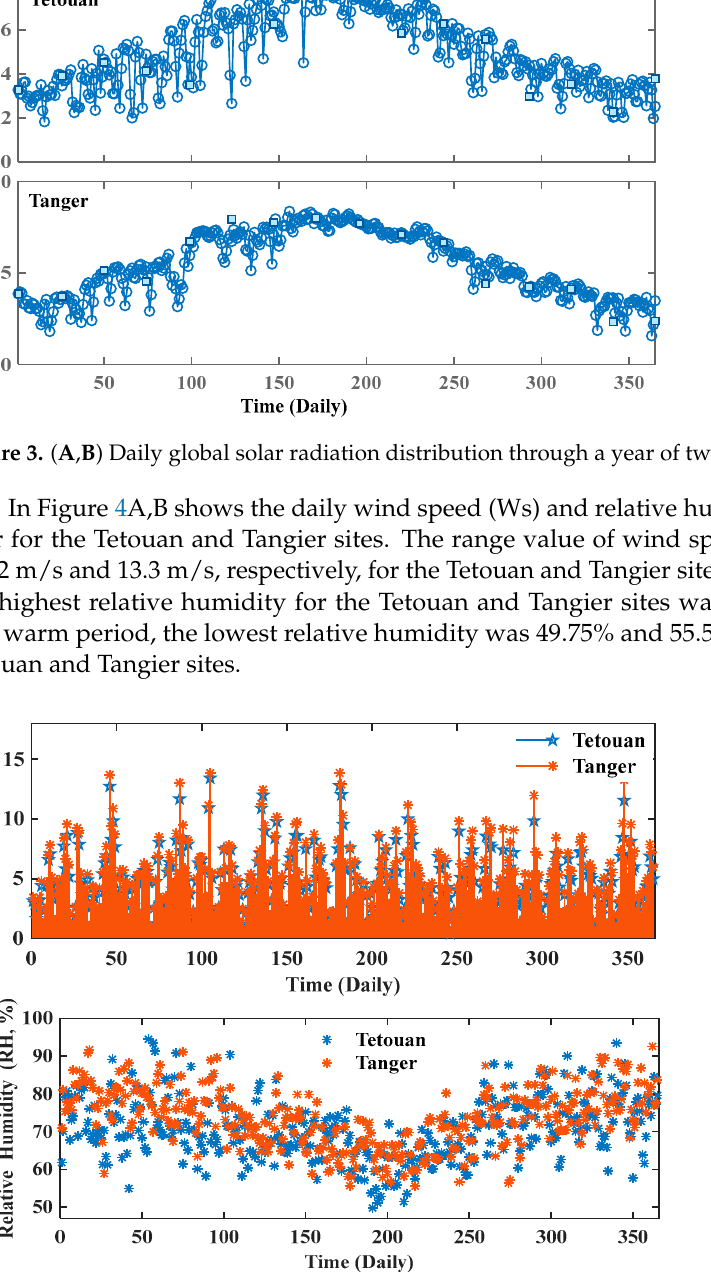
Figure 4. ( A ) Distribution of daily wind speed (m/s) and ( B ) relative humidity (%). The manipulations may require other types of meteorological parameters such as ambient temperature ( T , ◦ C; maximum, minimum, average, difference, and ratio), day number, day length, wind speed ( W s , m/s; average), relative humidity (RH,%), top of atmosphere radiation (TOA radiation), and geographic coordinates (Latitude, Altitude, and Longitude). These are exogenous data, whose periods and characteristics of measurements are summarized in Table 2. Table 2. Daily average inputs parameters data of Tetouan and Tanger sites. Cities